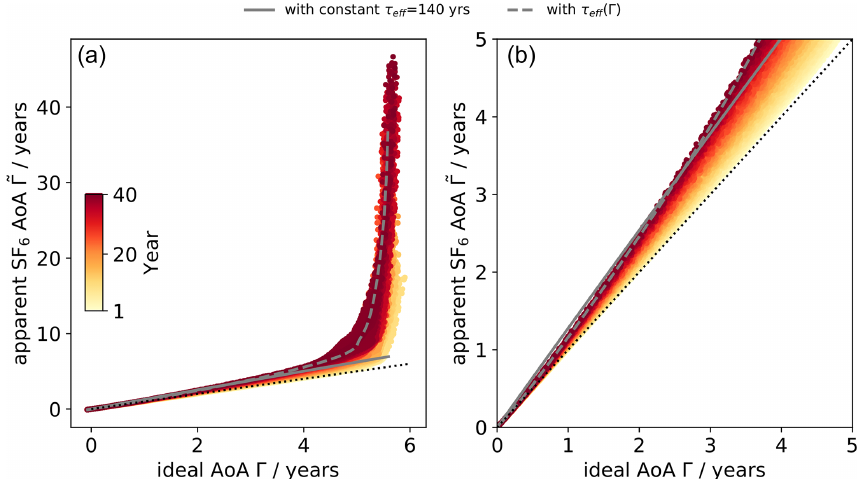
Figure 7. Midlatitude (30–50 ◦ N) averaged mean AoA from the ideal tracer plotted against the apparent mean AoA derived from the linearly increasing SF 6 -like tracer from the TS2000 simulations, for years ranging from year 1 (yellow) to year 40 (dark red). Panel (b) shows the same as panel (a) but is limited to ages below 5 years. The gray lines are estimations based on Eq. (11) for t = 40 years, with either a constant effective lifetime of 140 years (dashed) or with the effective lifetime dependent on (cid:48) (as shown in Fig. 8).